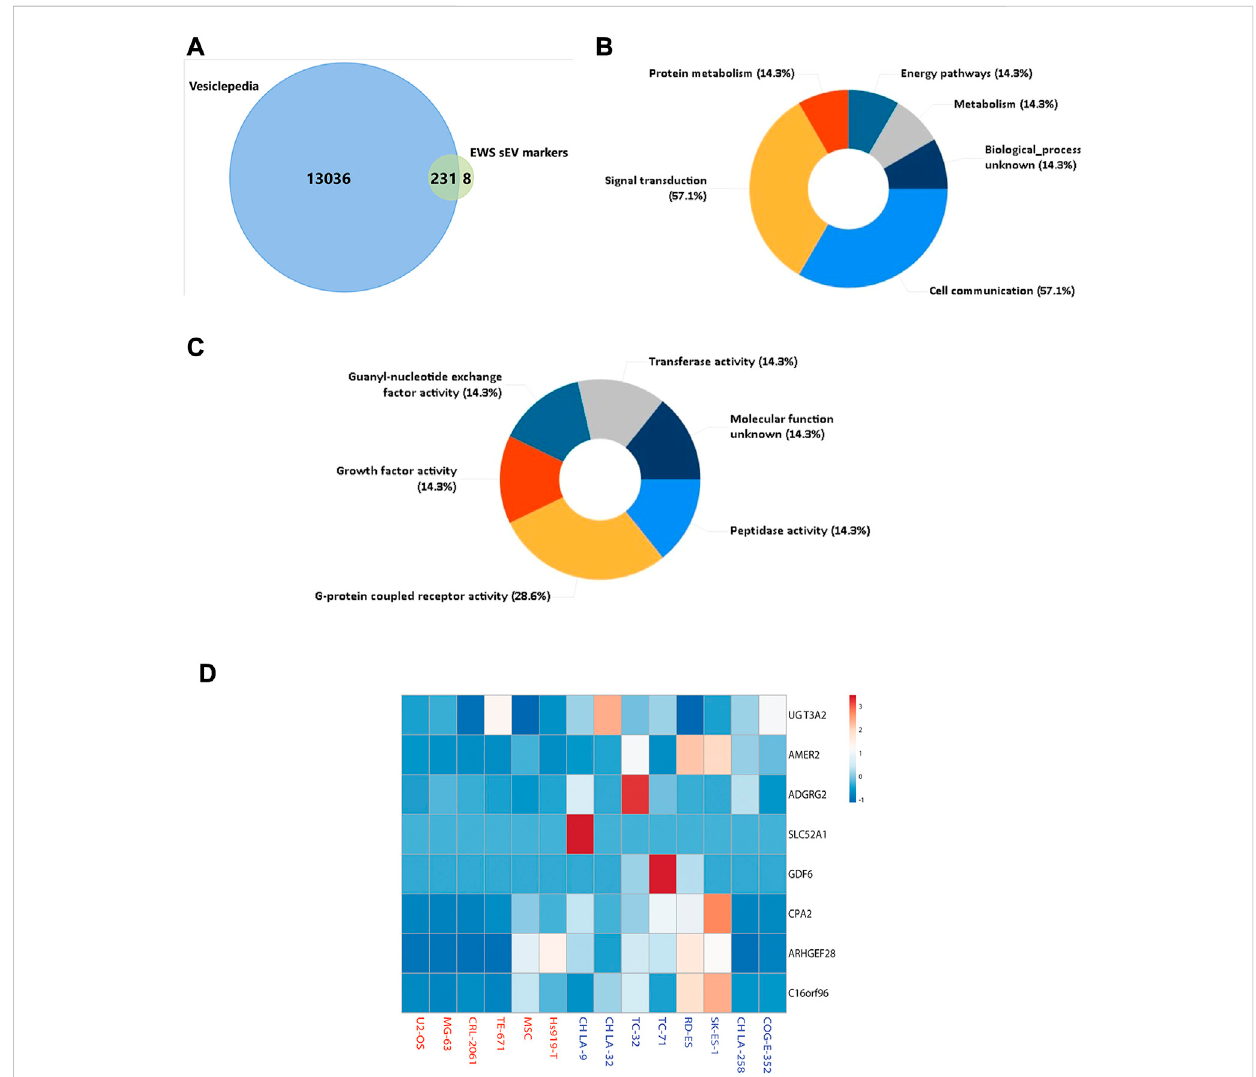
FIGURE 2 Characterization of EWS Speci fi c sEV (exo-) Proteins (A) Venn diagram representing proteins in Vesiclepedia and sEVs, eight unique proteins were identi fi ed in EWS sEVs. (B) Top-ranked over-represented biological processes and (C) predicted molecular functions for the eight EWS exo-protein markers. (D) . Heat map representation for expression of eight EWS exo-protein biomarkers using quantitative values. Rows are centered; unit variance scaling is applied to